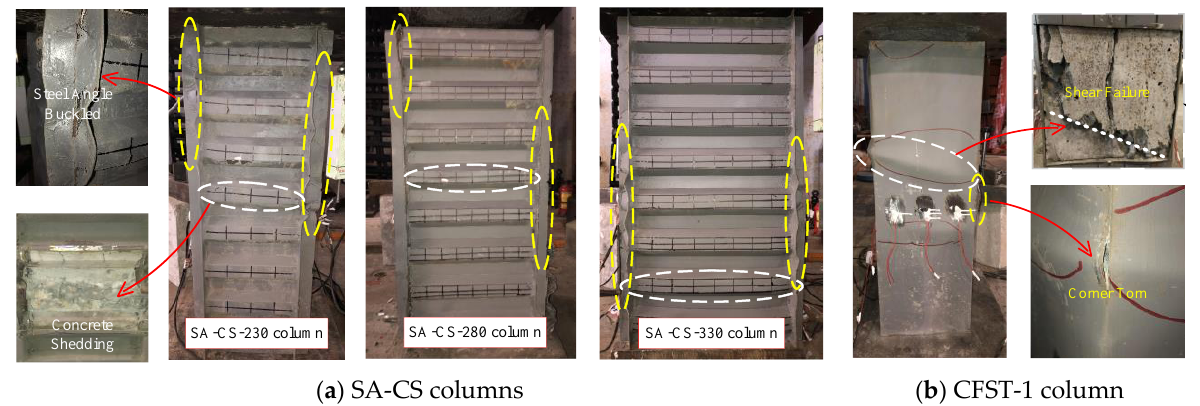
Figure 5. Failure modes of specimens.